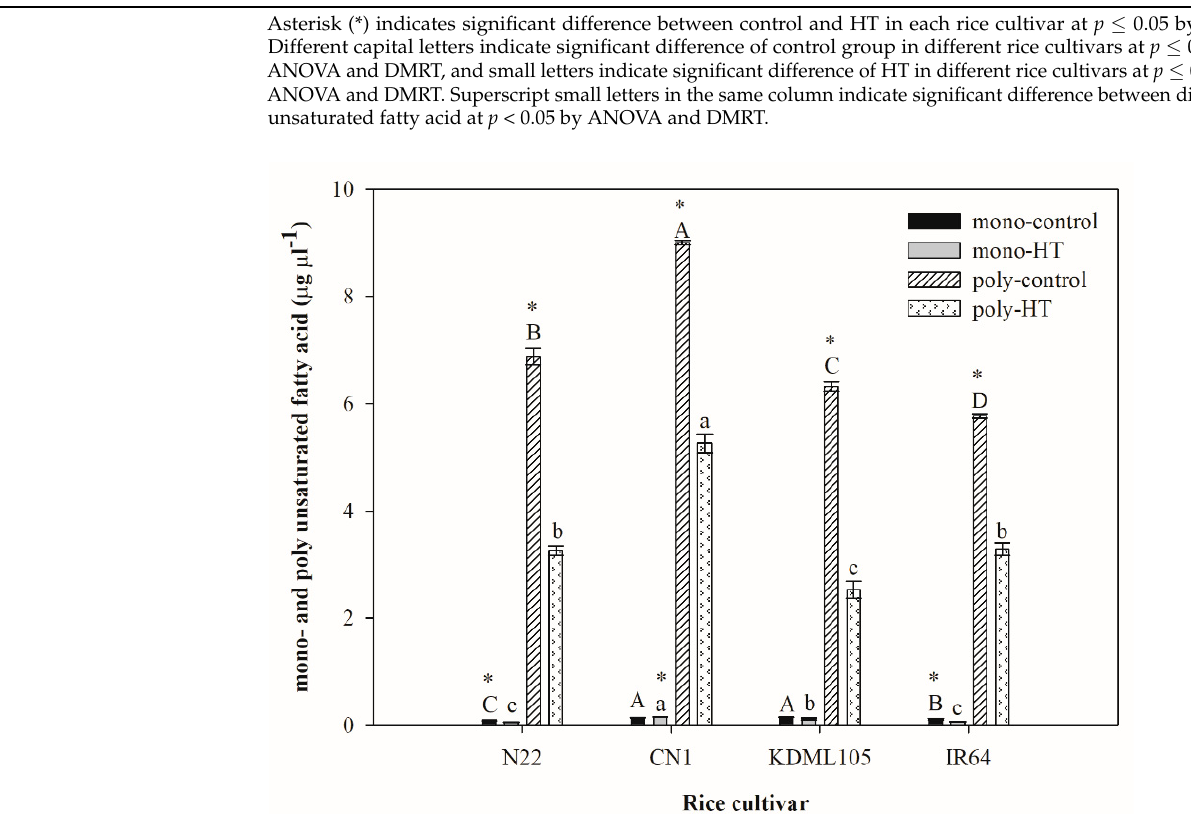
(Table 3). Sharp increases in Sat:Unsat after exposure to HT occurred in all rice cultivars in the range between 1.5–1.8-fold compared to the controls. The highest increase in Sat:Unsat was found in N22, and the lowest increase was found in